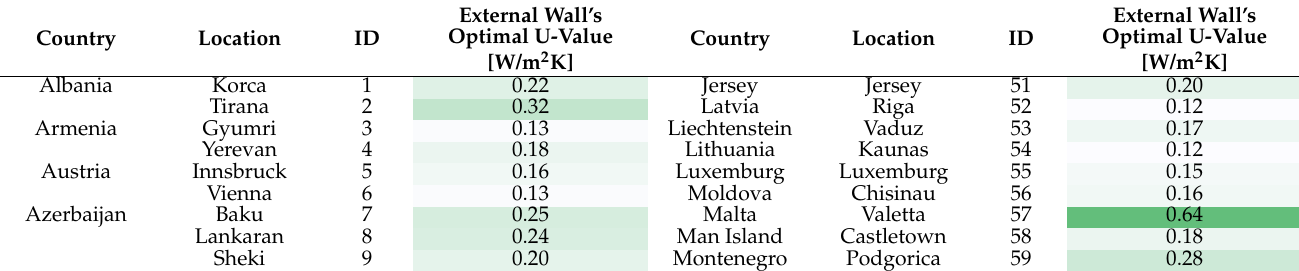
Table 3. External wall optimal U-value for the 100 selected locations in Europe (darker colours means higher U